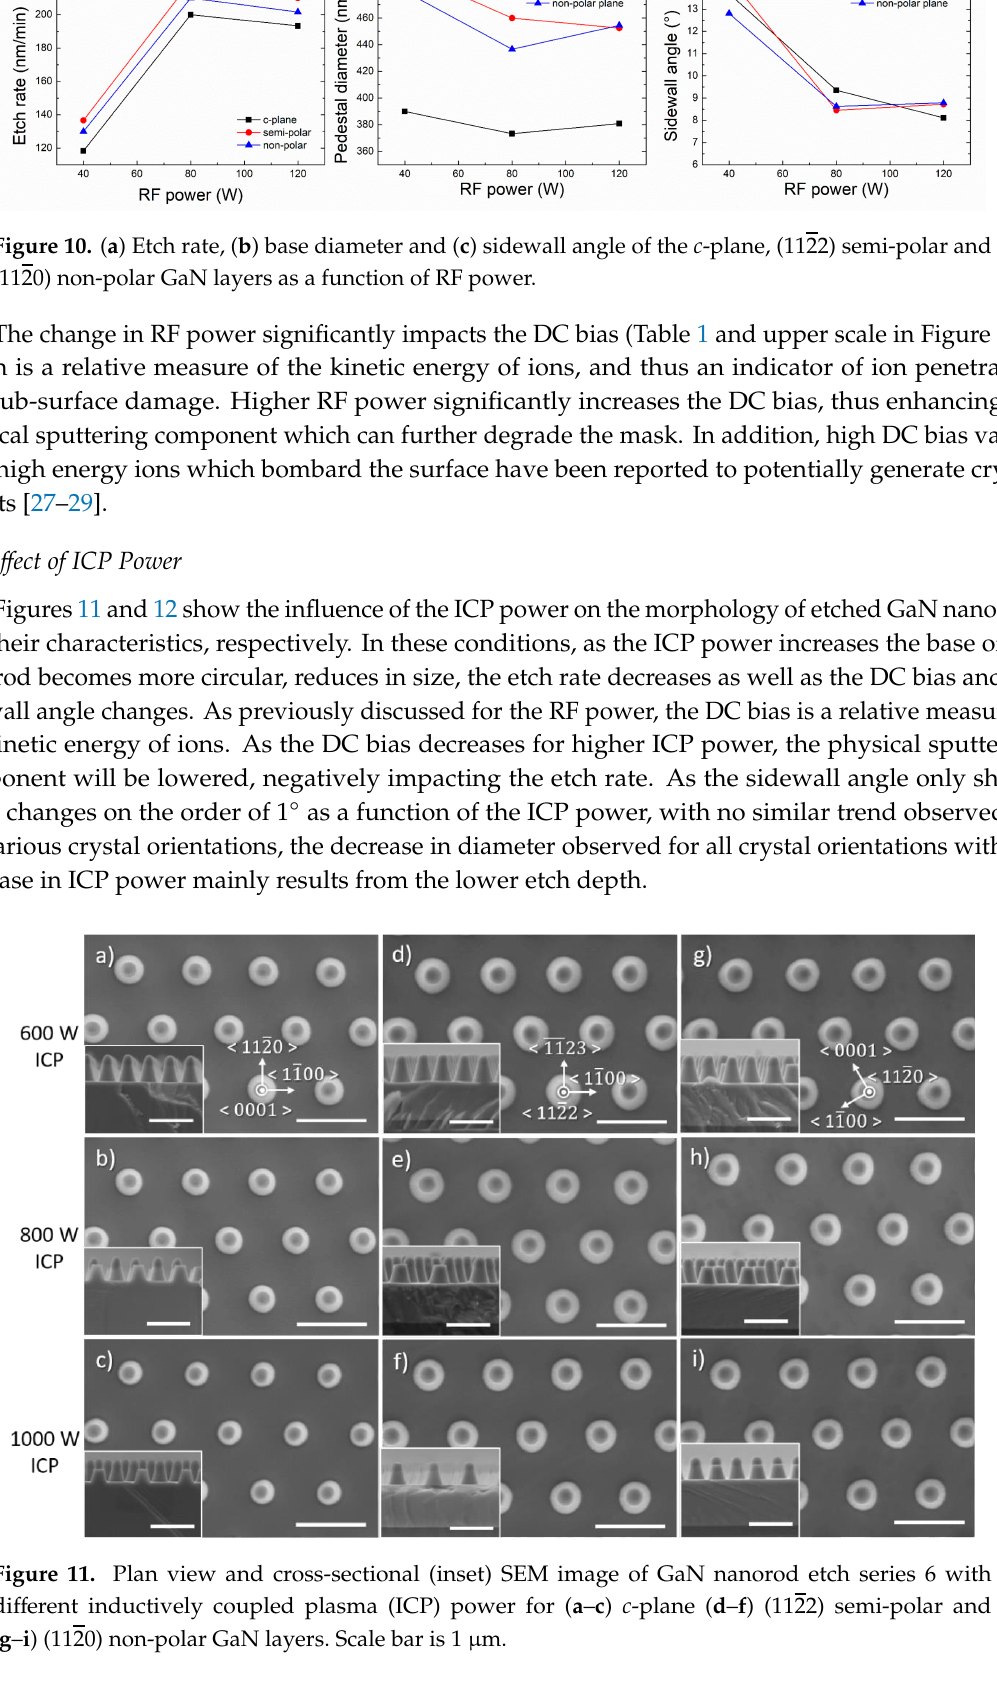
Figure 12. ( a ) Etch rate, ( b ) base diameter and ( c ) sidewall angle of c -plane. ( 112̅2 ) semi-polar and ( 112̅0 ) non-polar GaN layers as a function of ICP power. 3.6. Effect of Time The dependence on the etching duration has been performed for two etch times under two different conditions (Figure 13), either where the physical etching component or the chemical etching